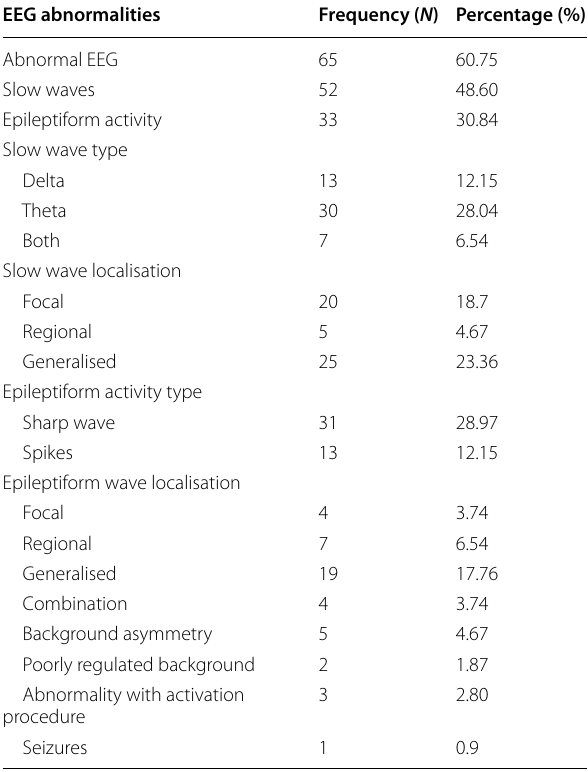
Table 1 Details of EEG abnormalities in clozapine-treated